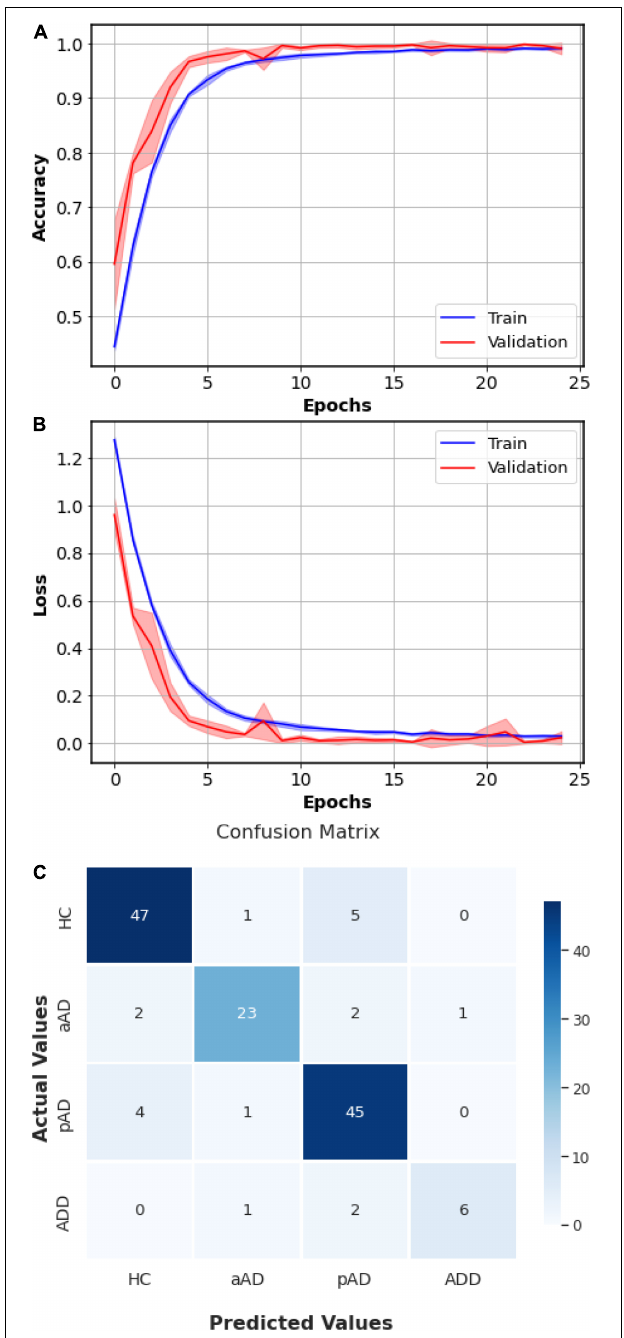
FIGURE 6 | Summarized history of Cognitive Neural Network-Long Short-Term Memory (CNN-LSTM) model’s accuracies (A) and losses (B) and conclusive confusion matrix (C) of the fivefold cross validation. In the accuracy and loss curves, the solid lines indicate the mean and the shadow areas represent the ranges over the